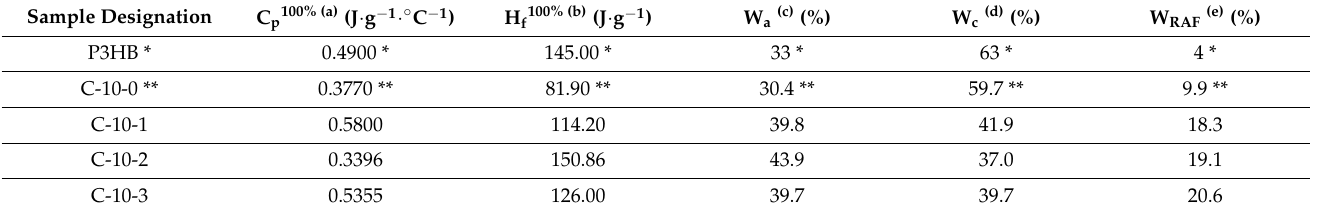
Table 4. Characterization of phase contents for the unfilled P3HB and its nanobiocomposites with